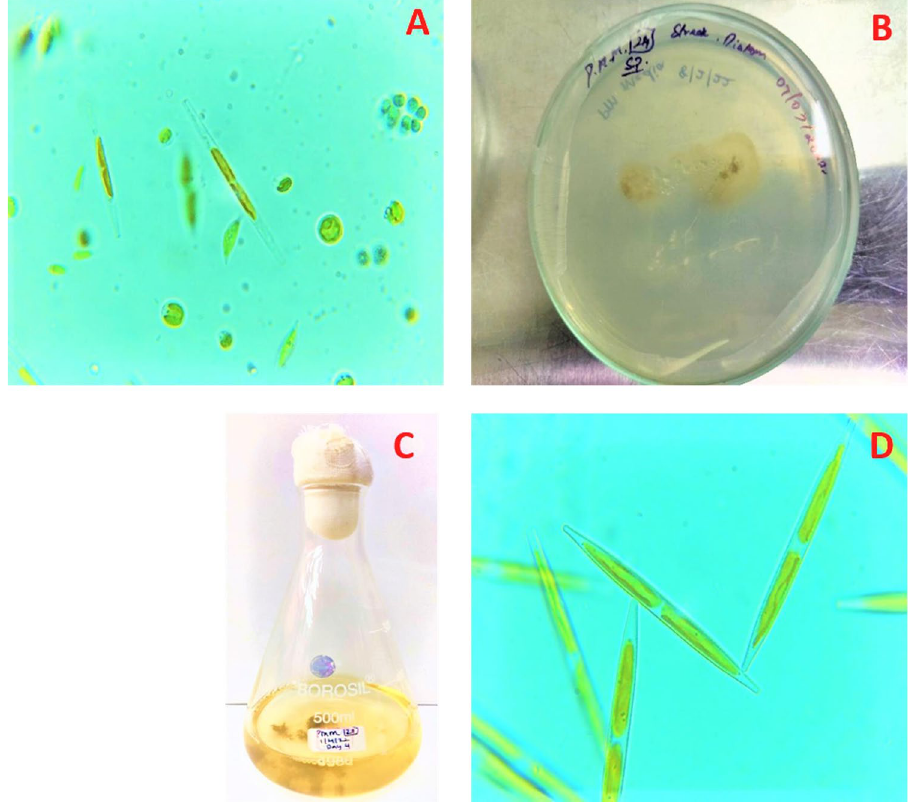
Figure 2. ( A ) Microscopic observation of freshwater sample collected from Chembarambakkam Lake (10 X magnification); ( B ) Spread plate technique showing diatom colony; ( C ) Isolated pure culture of Diatom